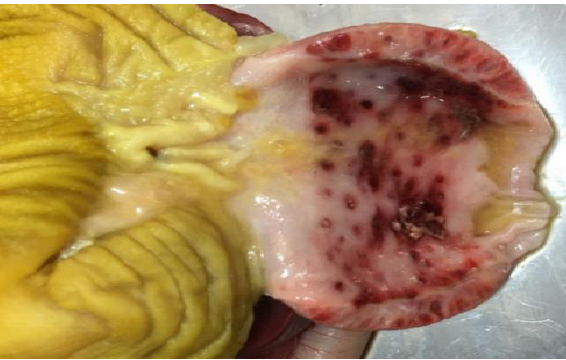
Figure,1: The proventriculus of experimentally infected birds showed severe petechial hemorrhages and necrotizing foci.